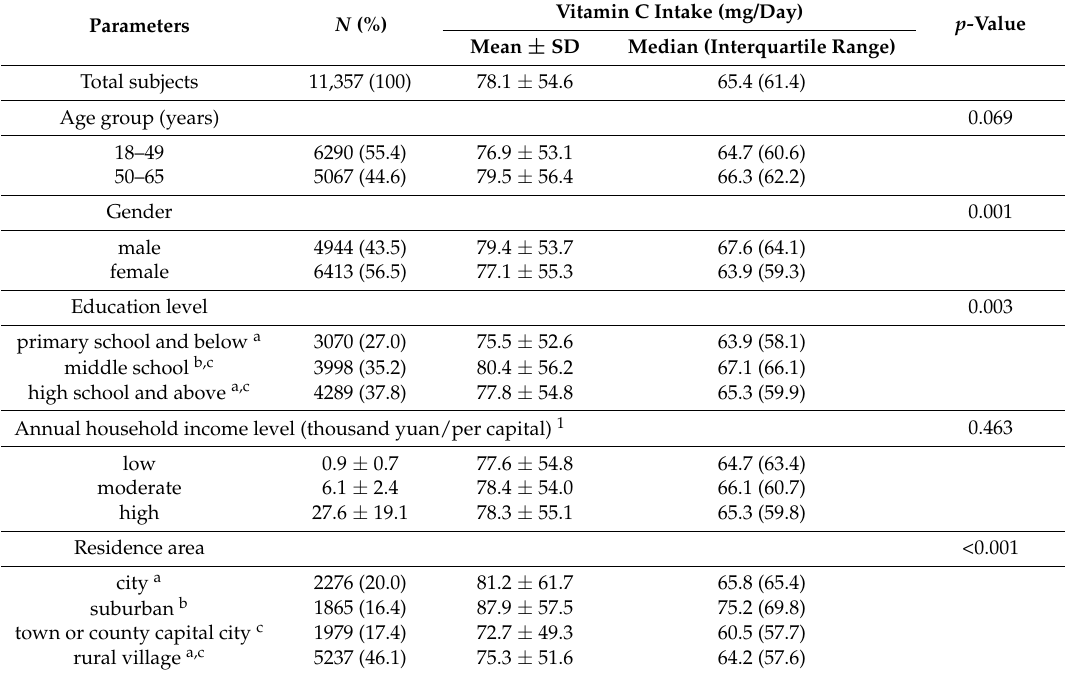
Table 1. Sociodemographic characteristics and daily dietary vitamin C intake in